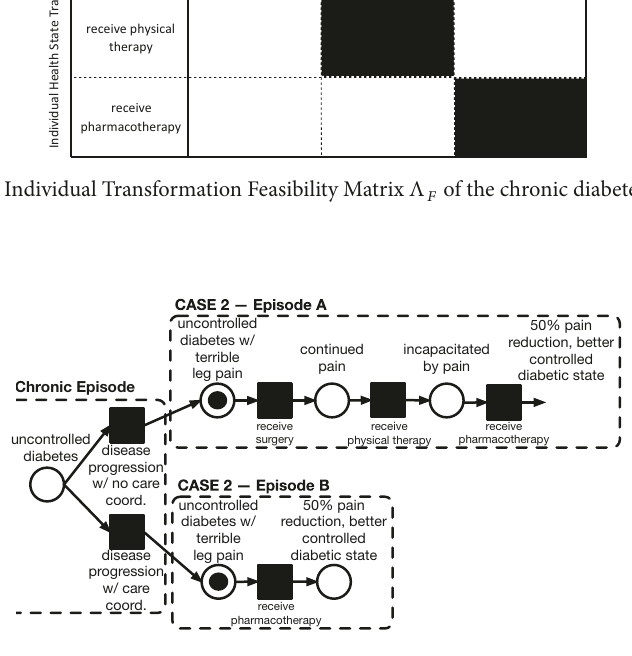
Figure 17: Chronic diabetes Individual Health Net illustrating two possible episodes (A or B) based on level of care coordination when disease progresses for an individual in a chronic episode. Health Net visualizes health states at the places (circles) and health state transformations, causing the changes in health state, at the transitions